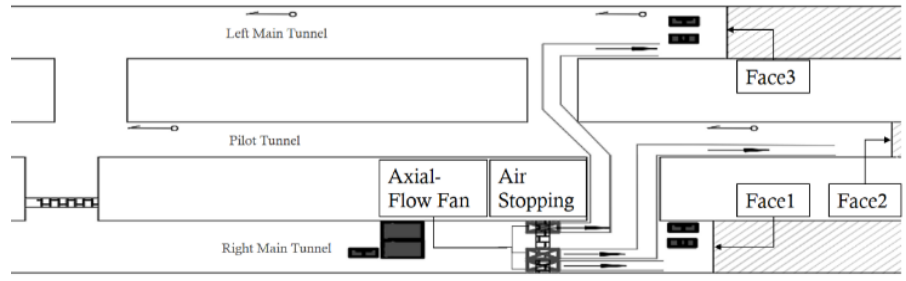
Figure 9. Ventilation arrangement.